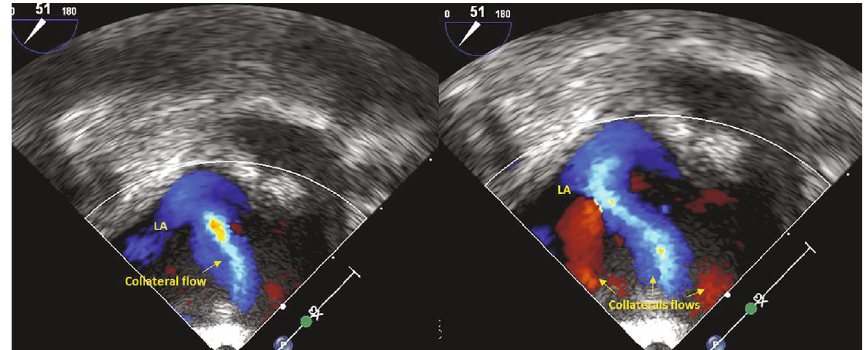
Figure 1: TEE shows multiple collateral fl ows at the os of the left superior PV with peak velocity of the predominant fl ow of 45 cm/s.